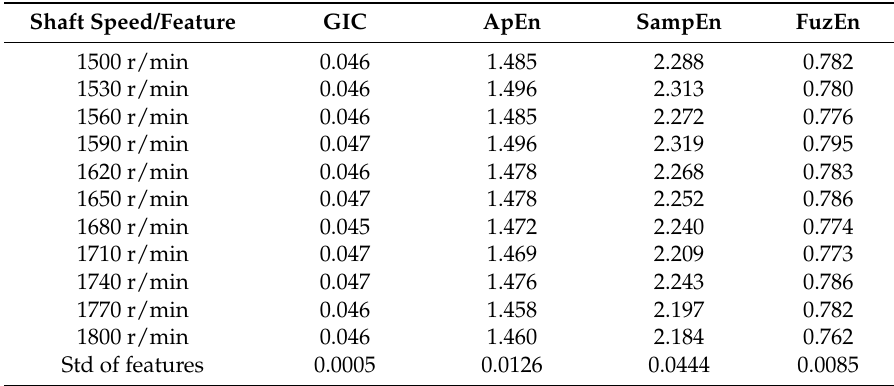
Figure 5. The simulated signal with different n s. Table 1. Features of the simulated